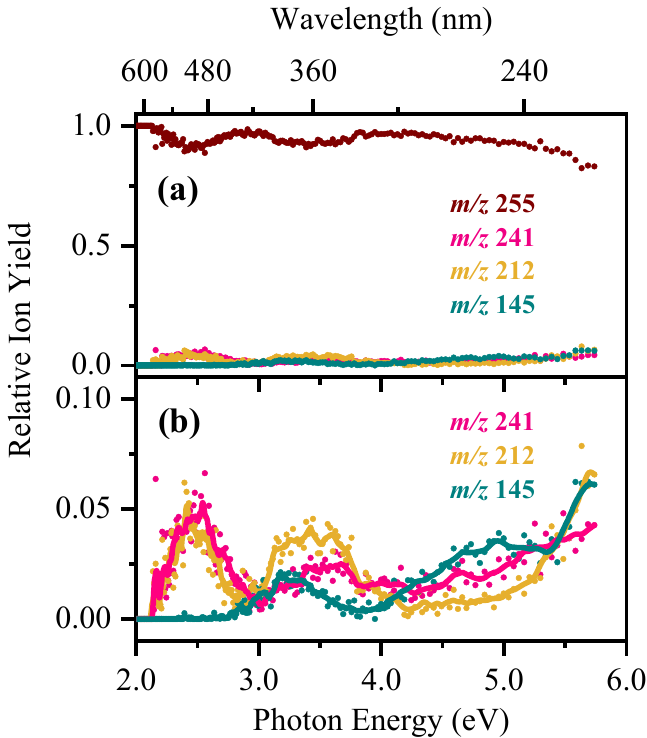
Figure 5. ( a ) Relative ion yield plot highlighting the relative ion yields of the 4 most dominant laser-induced [RF − H] − photofragments at m / z 255, 241, 212, and 145 between 2.0 and 5.74 eV. ( b ) Zoomed-in view of the data presented in ( a ), providing a clearer view the ion yields of the m / z 241, 212, and 145 photofragment ions.